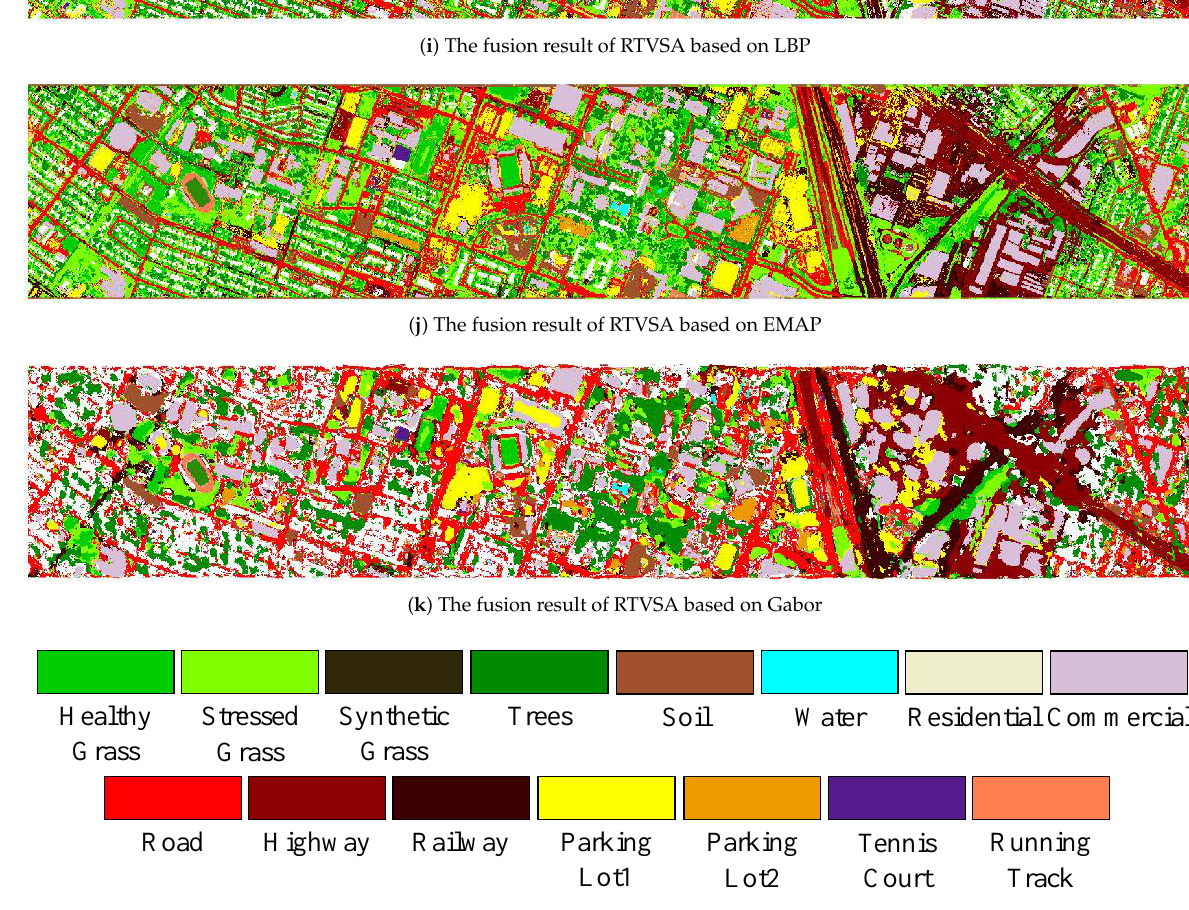
Figure 4. Classification maps obtained by RF classifiers combined with the proposed methods on the 2012 Houston